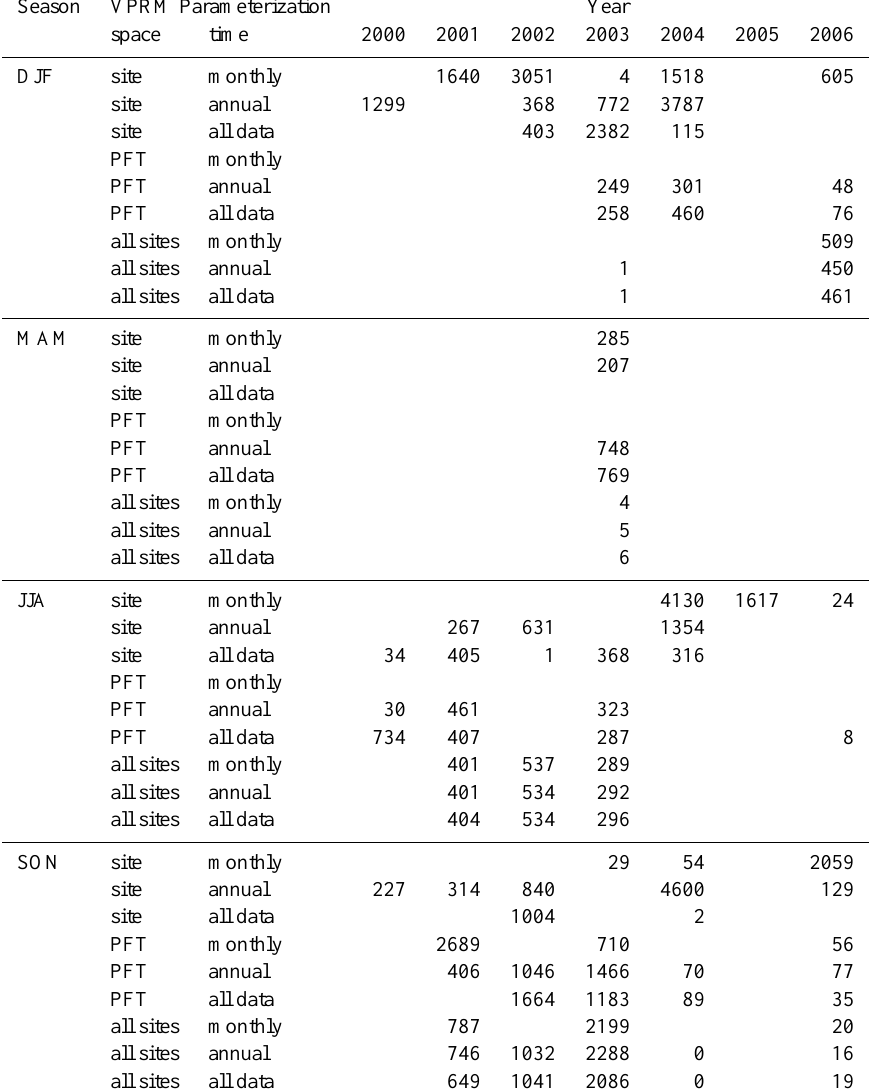
Table 3. Range parameter values (km) for VPRM flux error best-fit parametric variogram models. VPRM parameterizations are described in Table 2. Where a value is present, Akaike’s information criterion (AIC) analysis concludes the exponential variogram model fit more parsimoniously than the pure nugget model. Where the range is blank the pure nugget model fit most parsimoniously, indicating no spatial correlation is